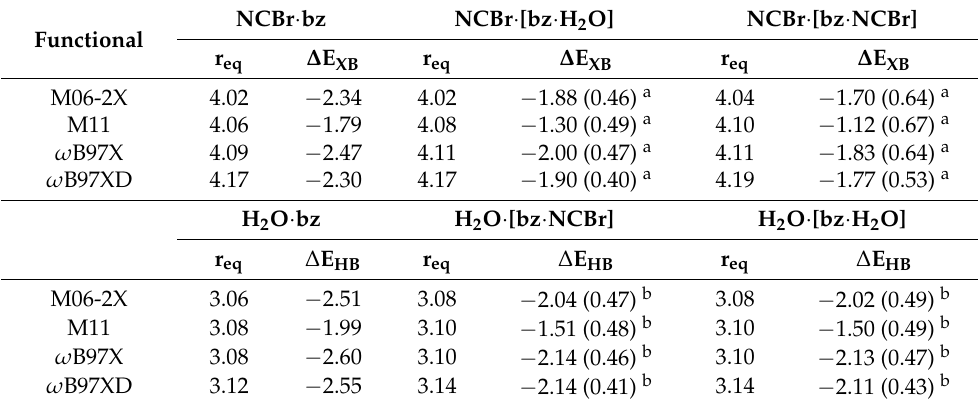
Table 2. Equilibrium distances r eq (Å) and interaction energies ∆ E XB and ∆ E HB (kcal/mol) for dimers and trimers in perpendicular configuration.